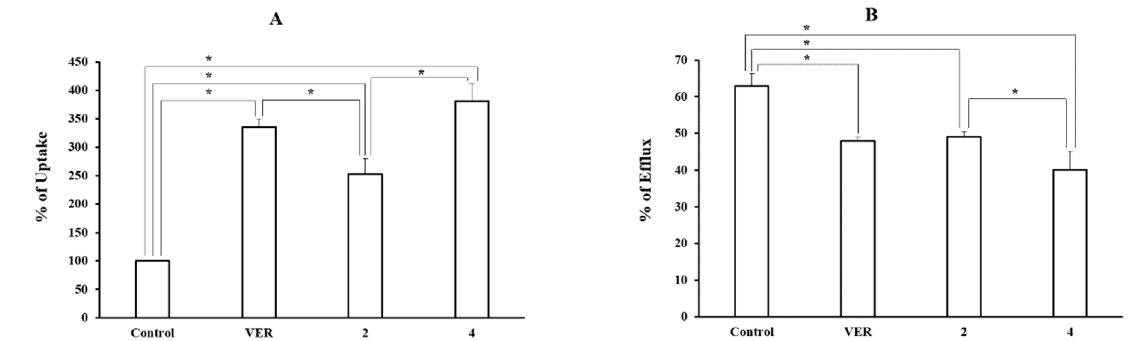
Figure 2. The Effect of 2 pre-selected derivatives on the uptake ( A ) and efflux ( B ) of [ 3 H]-DNM in MCF-7/ADR cells. [ 3 H]-DNM uptake and efflux were assayed after the incubation with each derivative (100 µ M) for 2 h and 1 h, respectively. VER was used as a positive control. Control represents uptake or efflux of tritium-labeled P-gp substrate alone. Each data represents the mean ± S.D. (*, p < 0.05) from triplicate experiments.